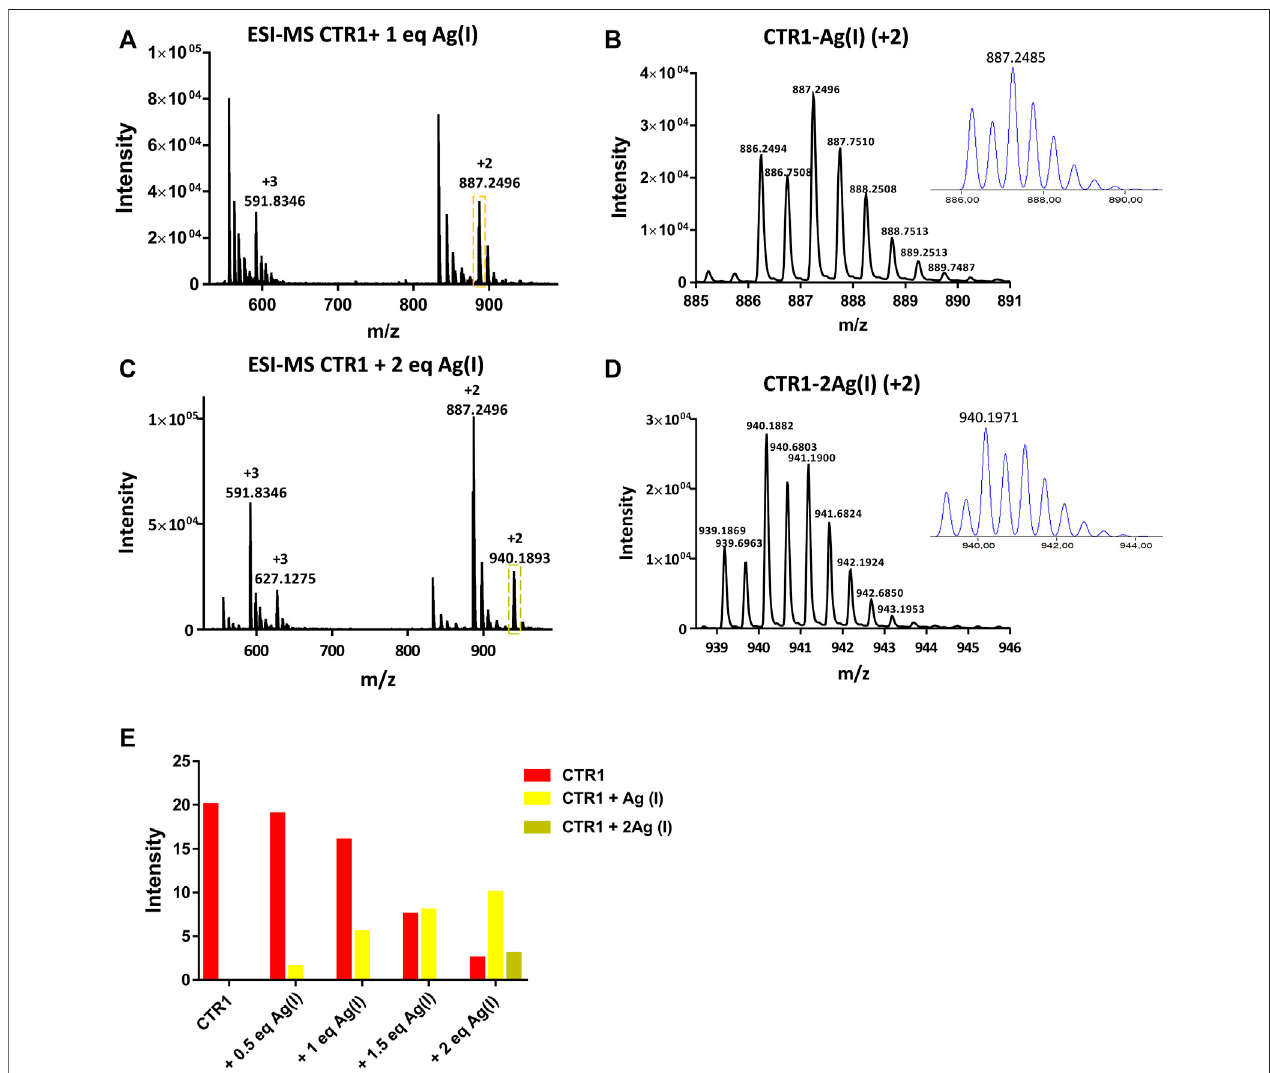
FIGURE 6 | ESI-MS spectra of Ctr1 1-14 treated with 1 and 2 eq of AgNO 3 (A,C) and magni fi cation of the doubly charged peaks ( yellow and green dashed boxes ) displayed in (B,D) , respectively; the insets show the calculated isotopic distributions. (E) Intensity of doubly charged ESI-MS peaks of different Ctr1 1-14 species as a function of Ag(I):peptide